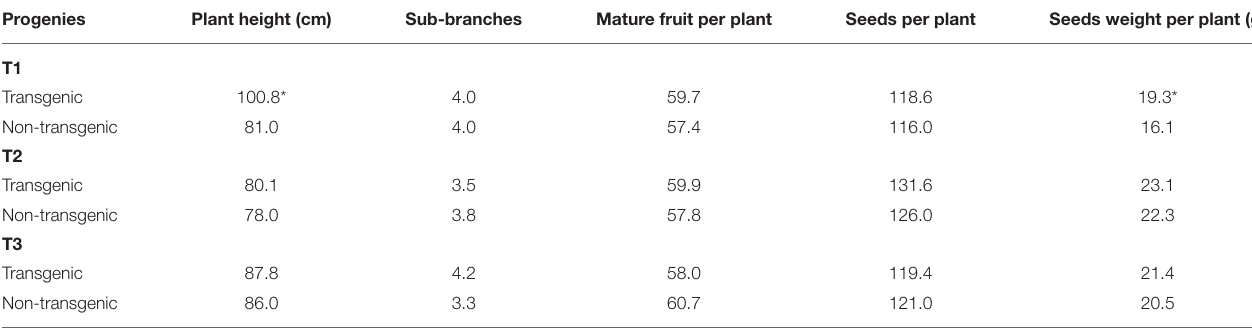
TABLE 5 | Growth and development of VX93 transgenic lines from T1 to T3 generations under field condition. Progenies Plant height (cm) Sub-branches Mature fruit per plant Seeds per plant Seeds weight per plant (g)